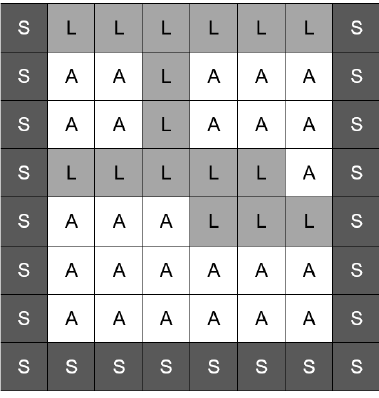
Figure 3. Marker grid 2D example.